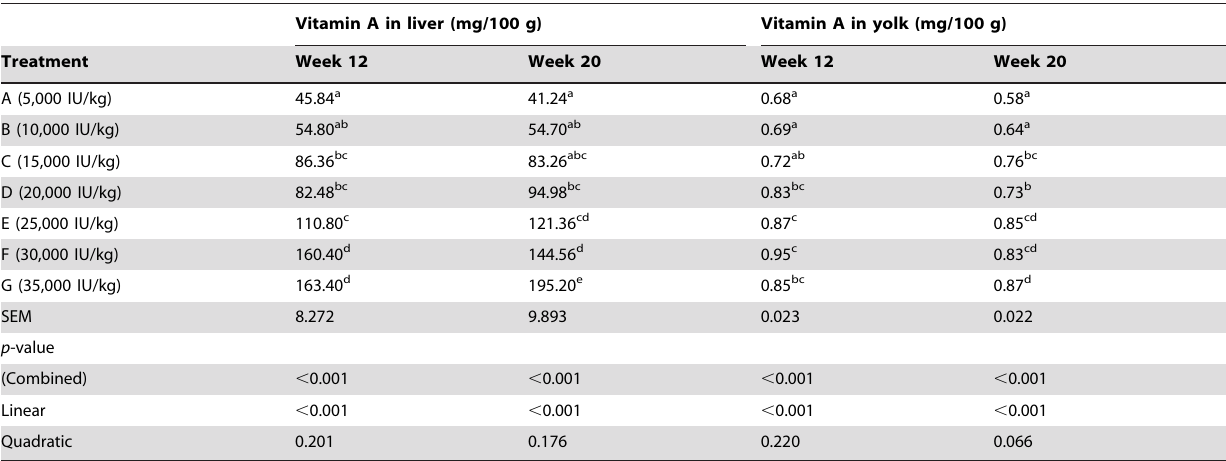
Table 6. Vitamin A concentration in liver and yolk (mg/100